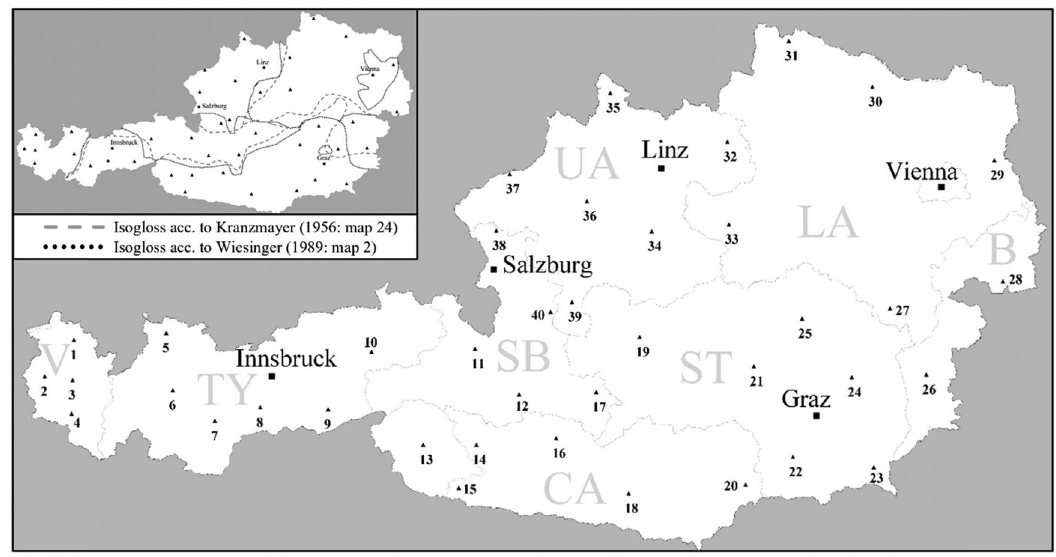
Figure 2: Research locations ( V = Vorarlberg, TY = Tyrol, SB = Salzburg, CA = Carinthia, ST = Styria, LA = Lower Austria, UA = Upper Austria, B = Burgenland; for the numbers see Table A1 in the appendix )